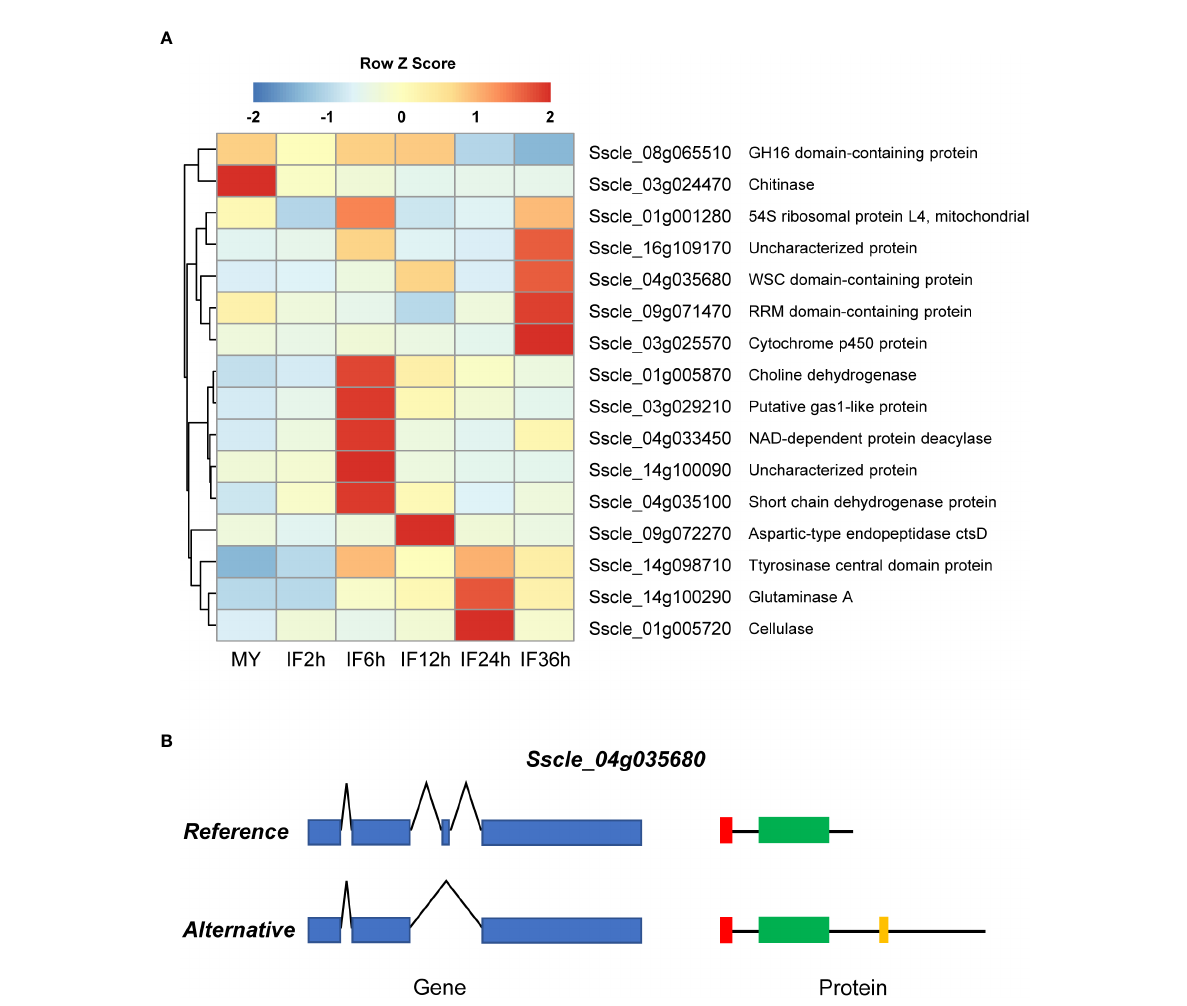
FIGURE 5 Modi fi ed functions of secreted protein-coding genes by alternative splicing (AS) in S. sclerotiorum . (A) The expression patterns of the secreted protein-coding genes undergo AS. (B) Schematic representation of Sscle_04g035680 produced by AS. The blue boxes and polylines indicate the exons and introns, respectively. The red boxes, green boxes, and yellow box indicates the signal peptides, WSC domains, and transmembrane domain,